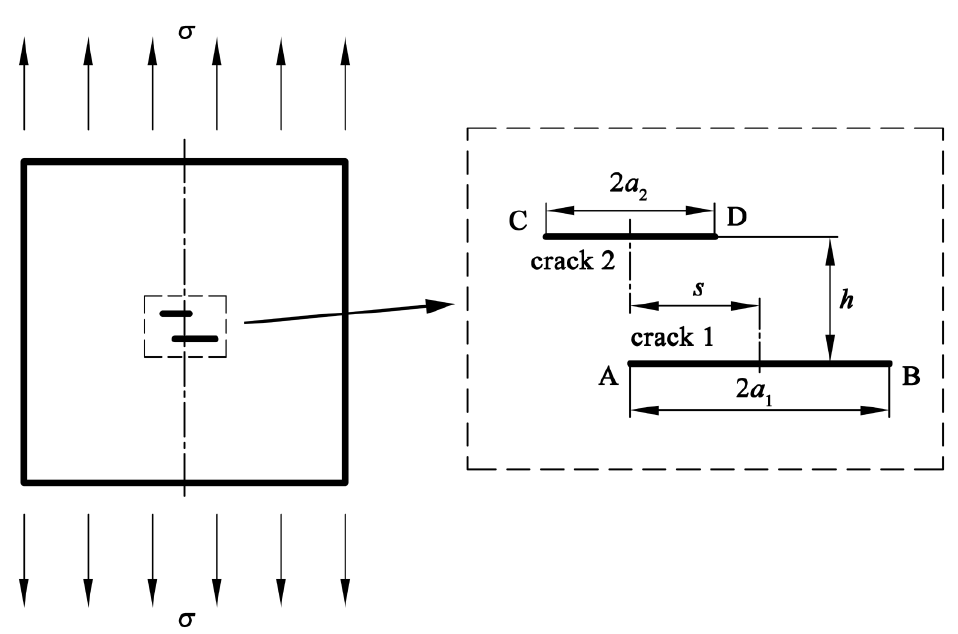
Figure 6. Finite element model of a plate with double parallel cracks.